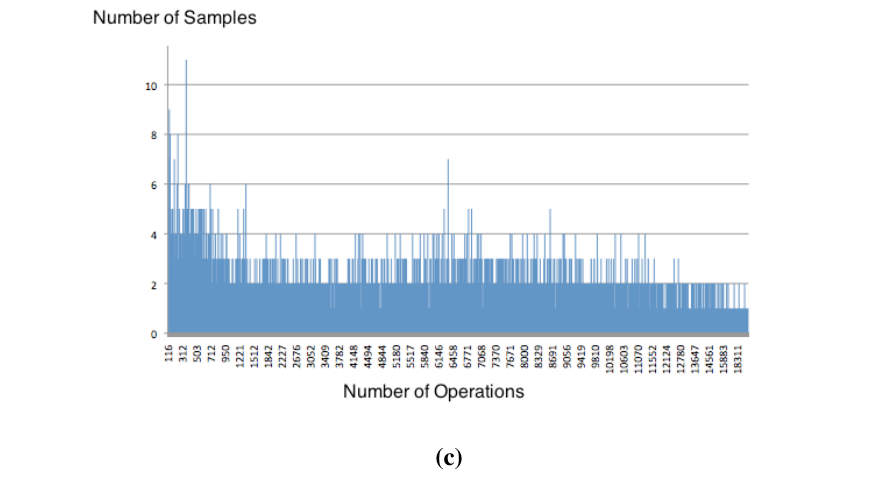
= 4 . 3 ; ( b ) Distribution found for n = 100 and m = 430 , m n